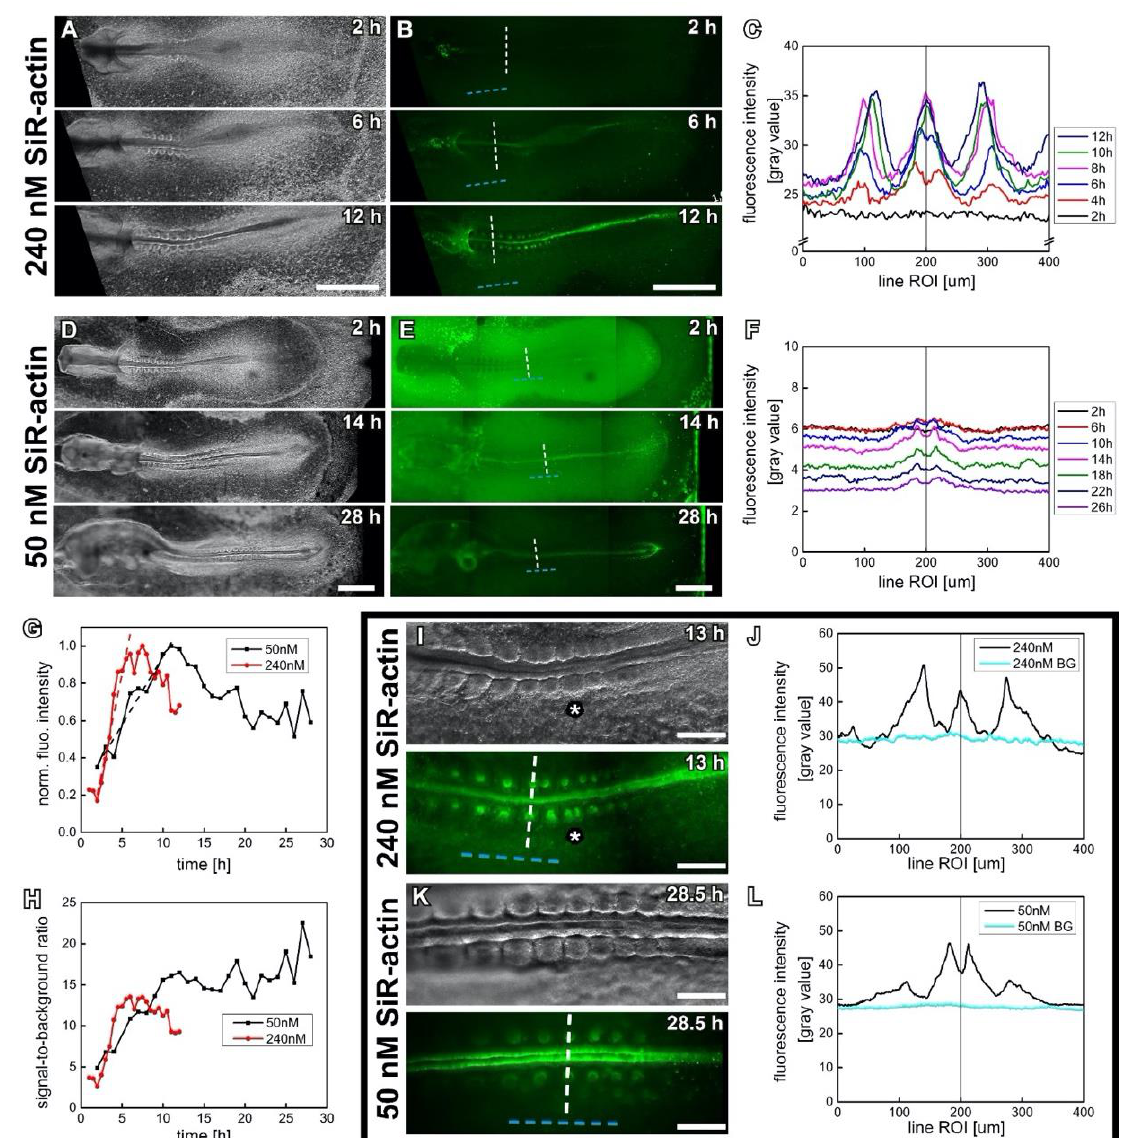
Figure 2. Embryonic development and gradual increase of SiR-actin fluorescence in chick embryos cultured ex ovo, representative images. Time-points indicate incubation time with SiR-actin. Anterior is always to the left. Scale bars, 1 mm ( A , B , D , E ), 250 µm ( I , K ). ( A ) Darkfield (DF) microscopic time-lapse frames of 3-somite stage embryo (HH7), cultured in presence of 240 nM SiR-actin. Development progressed up to the 10-somite stage (HH10) during 12 h of incubation. ( B ) Corresponding widefield fluorescence (WF) time-lapse frames of embryo shown in ( A ). Dashed lines indicate line region of interest (ROI) used to measure fluorescence intensities of embryonic midline (white) and surrounding structures (background, cyan). ( C ) Line intensity profile plots across embryonic midline as indicated in ( B ), selected time points. Central peak originates from neural tube fluorescence, lateral peaks from somites. Plots are aligned for the central peak. ( D ) DF images of 8-somite stage embryo (HH9 to 9+), incubated with 50 nM SiR-actin. Development progressed up to the 21-somite stage (HH13-14) over 28 h of incubation. ( E ) Corresponding WF frames of the embryos shown in ( D ). Fluorescence signal builds up slower and less strong than ( B ). ( F ) Line intensity profile plots across the embryonic midline as indicated in ( E ). Plots are aligned to the single peak originating from the fluorescence of neural tube. ( G ) Temporal development of the normalized integrated intensity of fluorescence originating from neural tube at 240 nM and 50 nM SiR-actin concentration. Linear fitting of initial phase shows: fluorescence increases by 21%/h (240 nM) and 7%/h (50 nM). ( H ) Temporal development of signal-to-background ratio (SBR) for different SiR-actin concentrations. SBR was calculated as a ratio between integrated intensity of midline fluorescence and averaged intensity of background fluorescence (cyan dotted line parallel to embryonic midline in ( B , E )). ( I ) Higher magnification DF- and WF-images of the posterior somitic mesoderm of embryo in ( A , B ). Incomplete separation of somites indicated (*). ( J ) Line intensity profile plot along dashed lines in ( I ). ( K ) Higher magnification DF- and WF-images of the posterior somitic mesoderm of embryo in ( D , E ). Regularly shaped somites and specific F-actin signal visible, showing that 50 nM SiR-actin is sufficient for imaging at higher magnifications. ( L ) Line intensity profile plot along the dashed lines indicated in ( K ), revealing a significantly increased signal strength (compare with ( F )). Image capture settings: ( A , B ) Zoom 2.5, single tile acquired, image size 2048 × 2048 pixels, pixel size 2.6 µm × 2.6 µm, exposure time Cy5 channel 450 ms, darkfield channel 3.5 ms. ( D , E ) Zoom 3.1, three tiles (10% overlap)